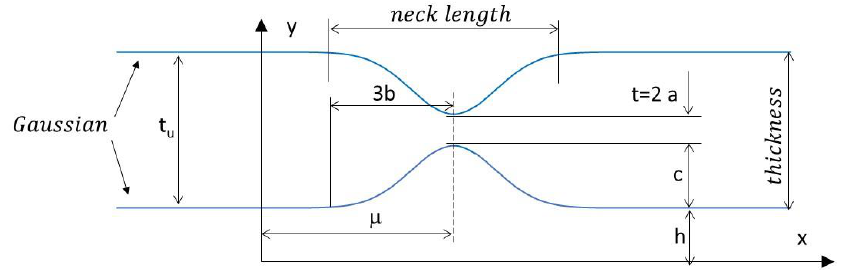
Figure 6. Schematic illustration of Gaussian contour fitting within the diffuse necking zone.